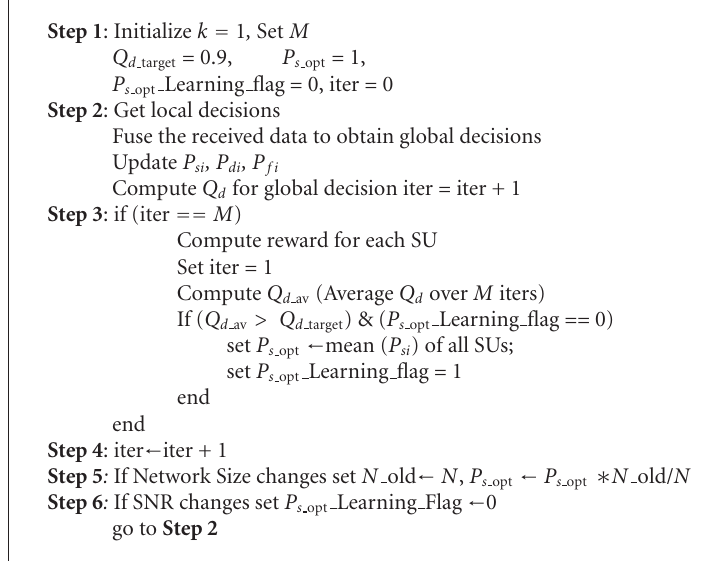
Algorithm 1: Adaptation algorithm at the spectrum coordinator (SC).